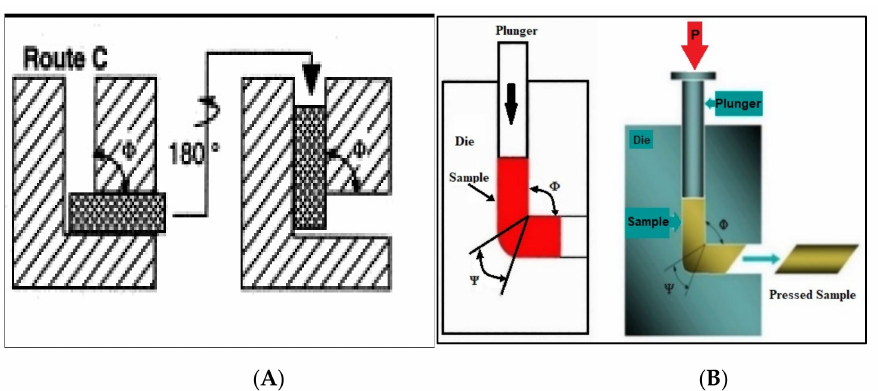
Figure 2. A schematic diagram of equal-channel angular pressing (ECAP) die: ( A ) route C path, ( B ) three-dimensional (3D) presentation of ECAP